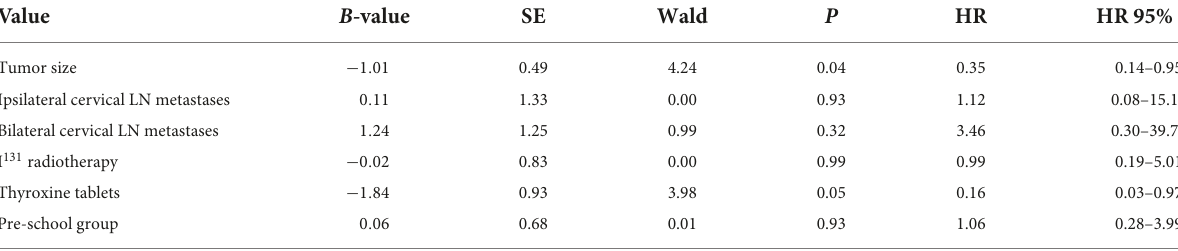
TABLE 4 Multivariate Cox regression models for predicting